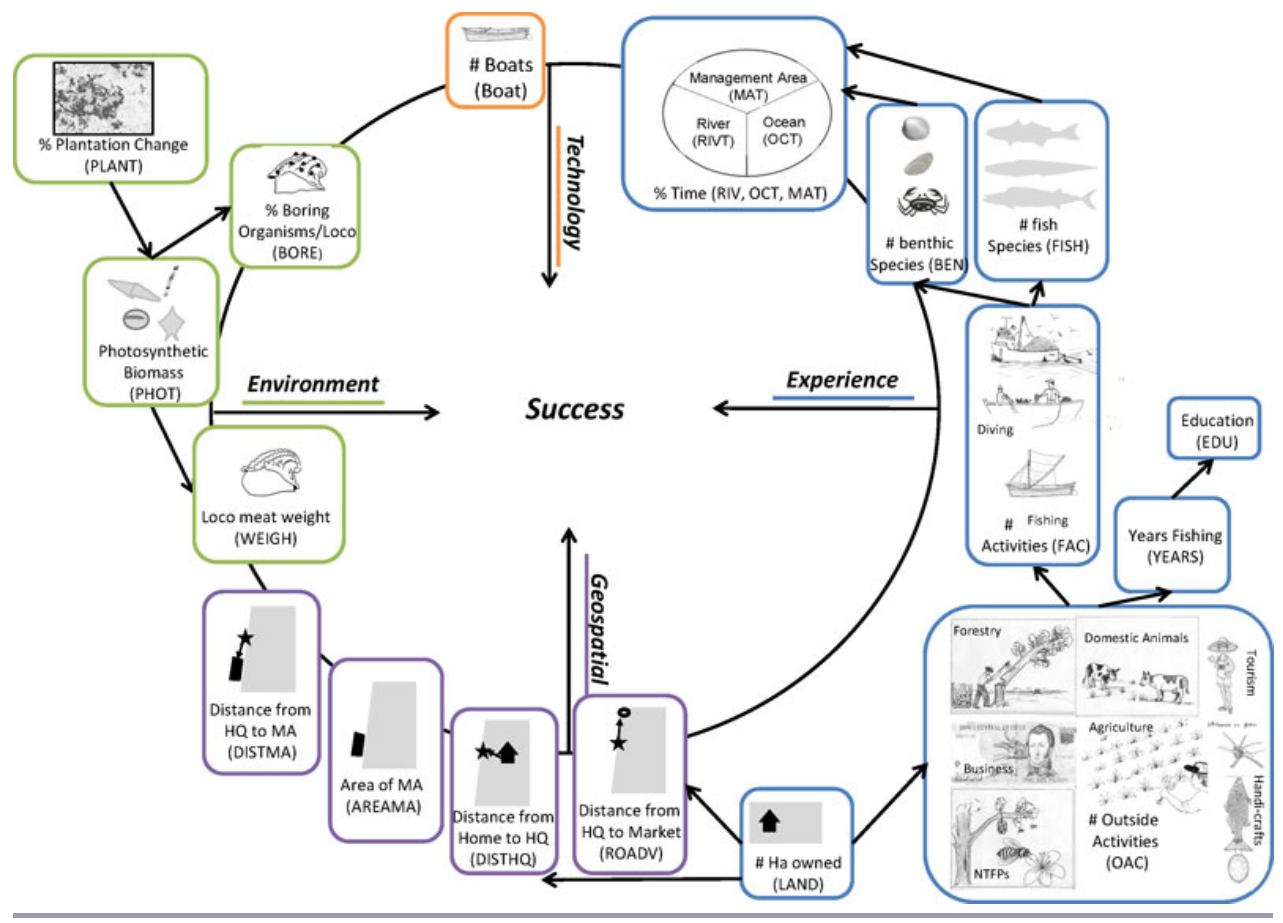
Fig. 2 . Conceptual framework for how technology, experience, and environmental and geospatial factors influence fisher